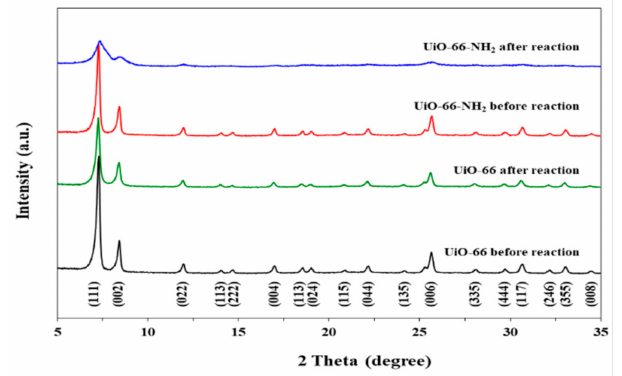
Figure 3. XRD spectra of UiO-66 and UiO-66-NH 2 .